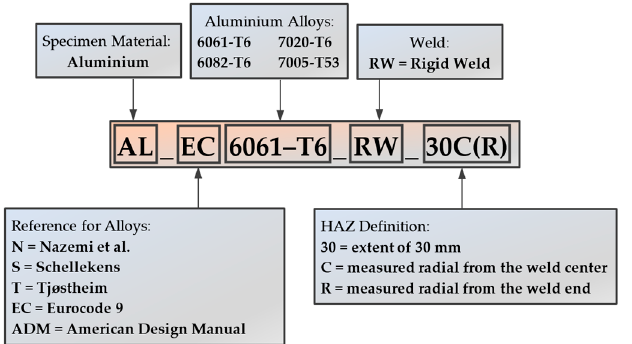
Figure 3. Nomenclature system of specimens; Nazemi et al. [25], Schellekens [60], Tjøstheim [61], Eurocode 9 [7,9], American Design Manual [28].